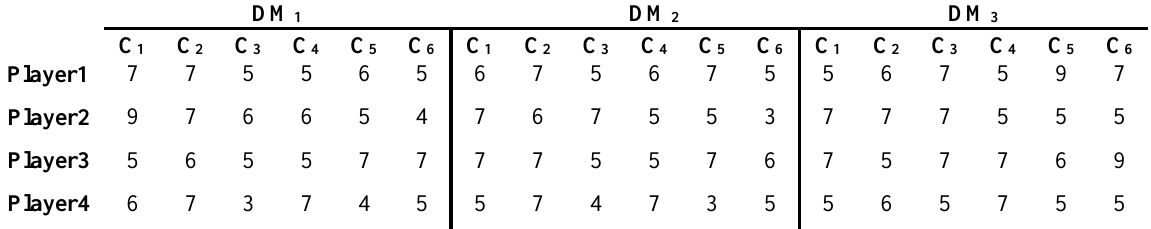
Table.4 . decision matrixes of each DM